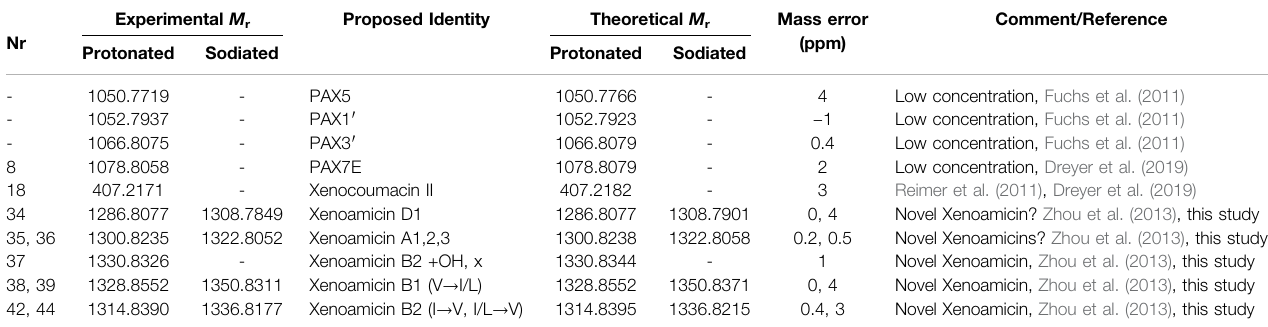
TABLE 3 | Summary of previously identi fi ed secondary metabolites in the extracts of the three different Xenorhabdus cultures using high resolution UPLC-MS and MS analysis, as well as genetic analysis to con fi rm group identity. Refer to Figures 2 – 4 ; Table 2 for UPLC-MS and Supplementary Figures S1, S2 and S5 for high resolution MS analyses and